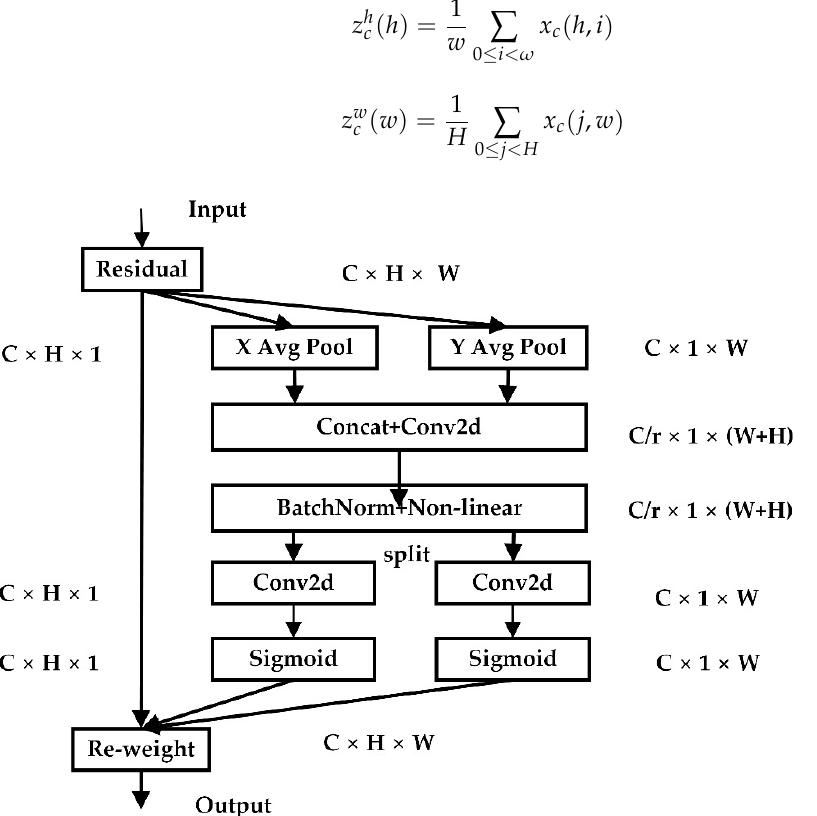
Figure 7. CA module